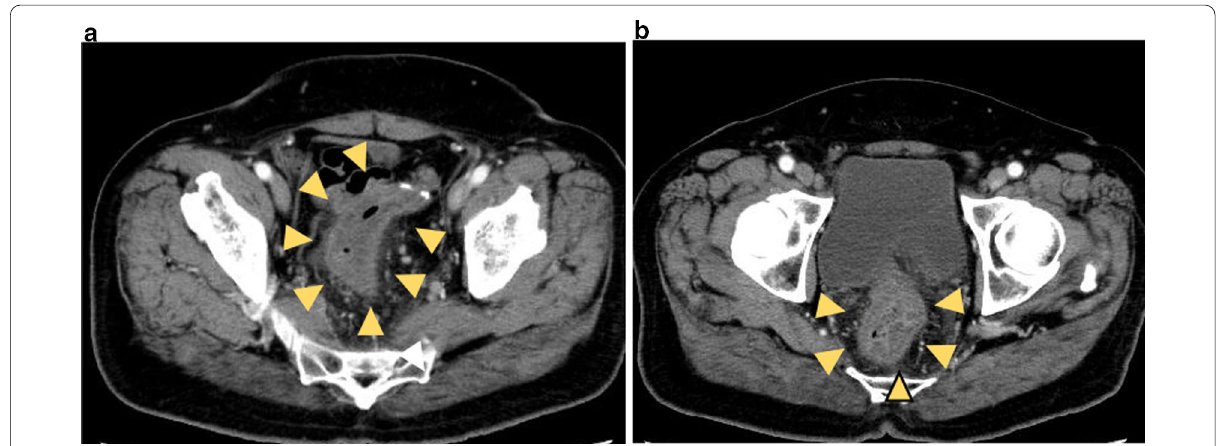
Fig. 4 Abdominal computed tomography findings. The images show edematous changes in the anal side of the anastomosis (yellow arrow). a The severest part of the ischemic lesion is not located adjacent to, but b is located at a short distance from the anastomosis towards the anal canal